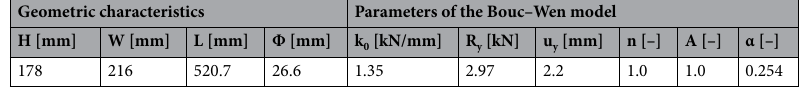
Table 1. Geometric and mechanical properties of the wire ropes.